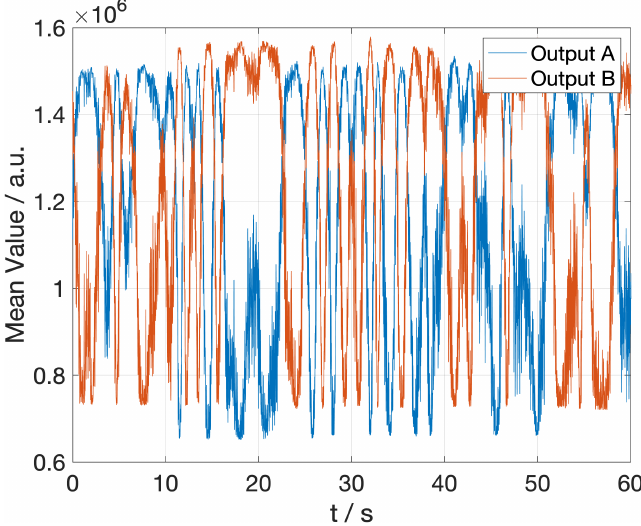
Figure 5. Demonstrator measurement obtained without any external phase